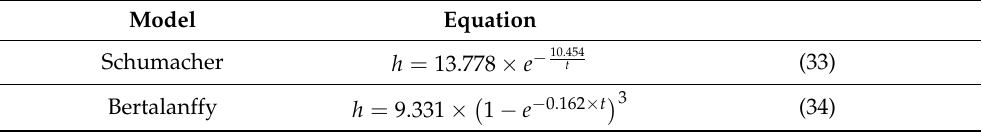
Table 6. Equations generated based on the coefficients shown in Table 5, where h —height; e —Euler’s number; t —time.